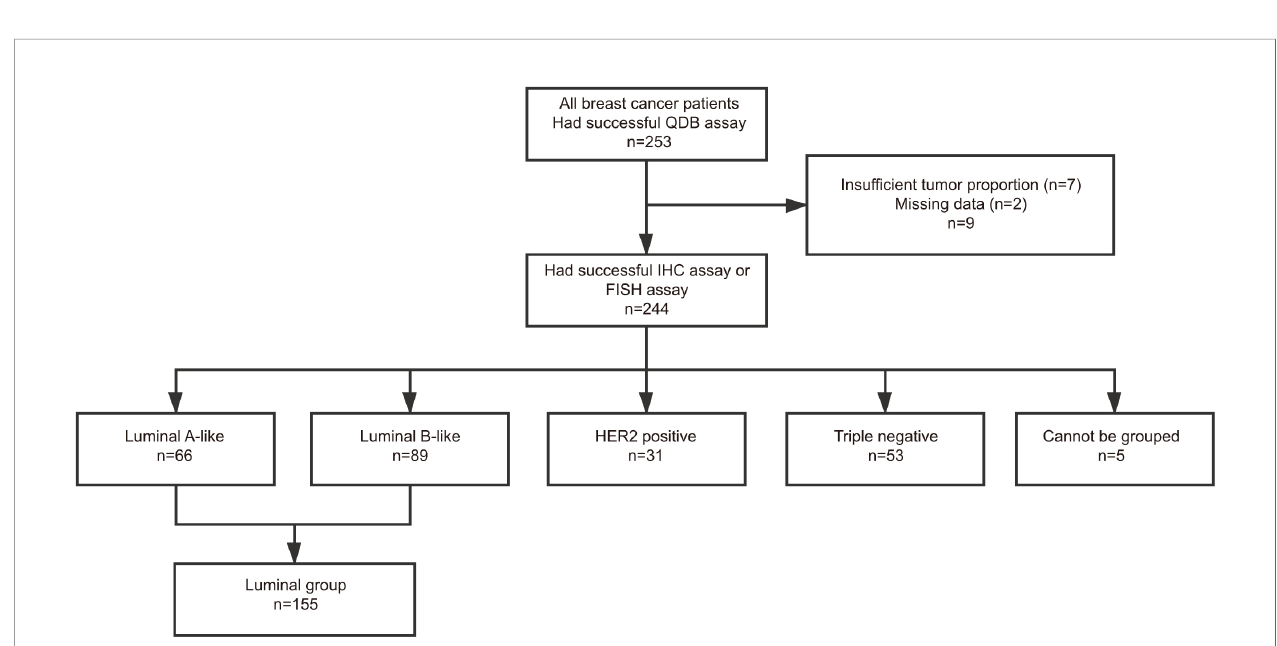
FIGURE 2 | Flow diagram of patient selection for the